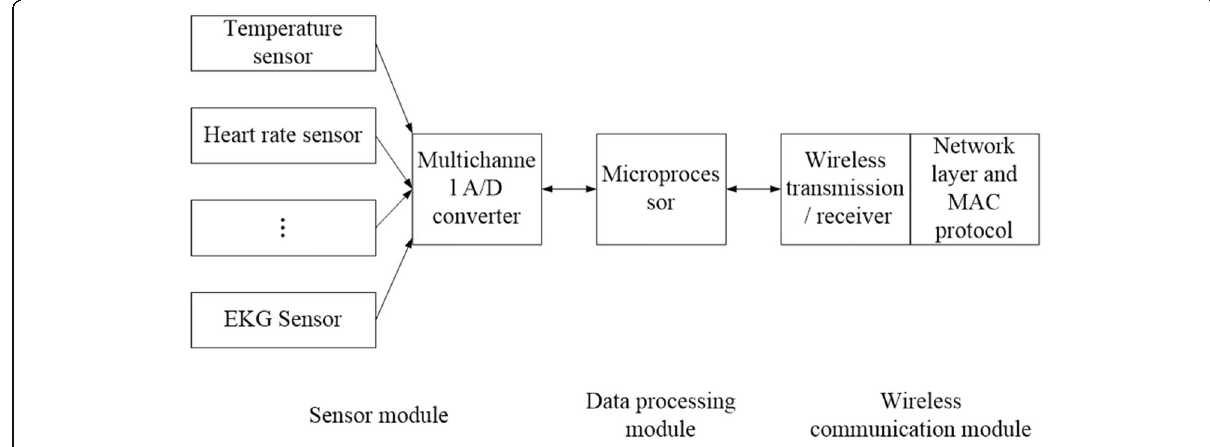
Fig. 3 Hardware design block diagram of medical monitoring